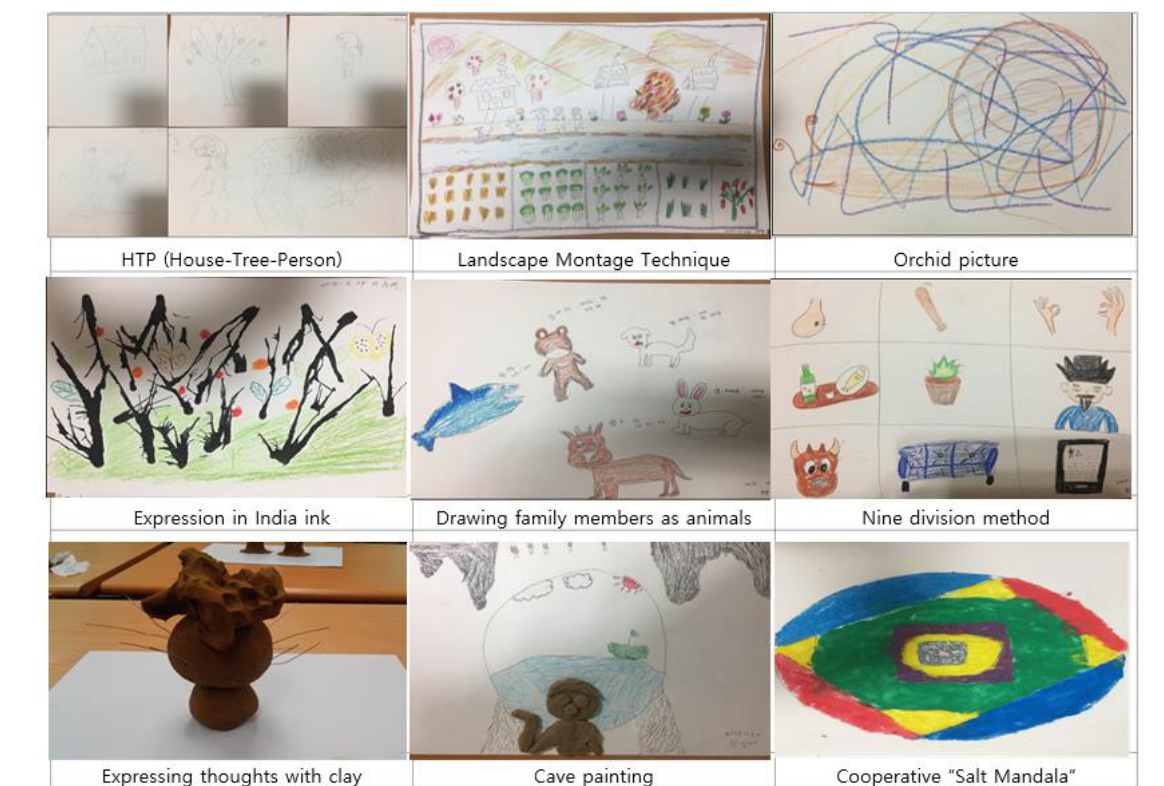
Figure 4. Artworks completed during the group art therapy intervention.